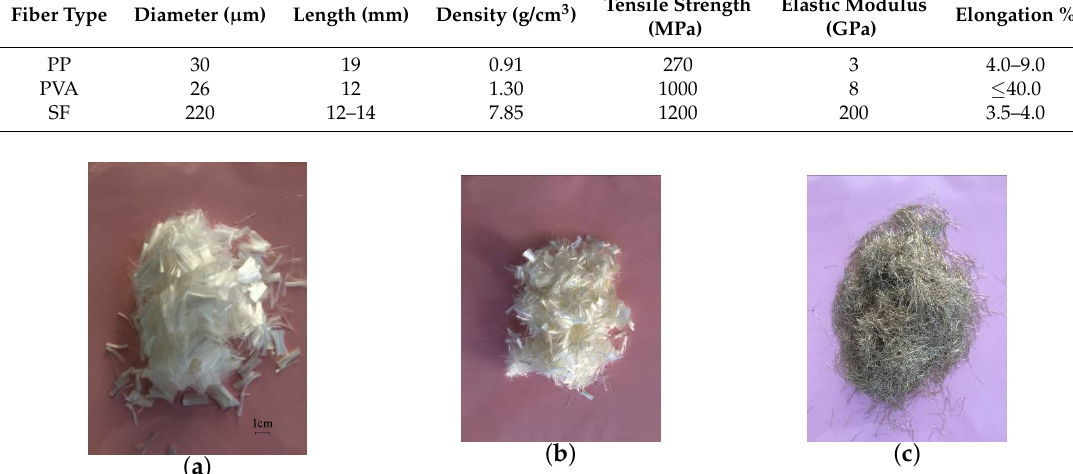
Figure 2. Fiber examples used in this work. ( a ) Polypropylene fiber; ( b ) Polyvinyl alcohol fiber; ( c ) Steel